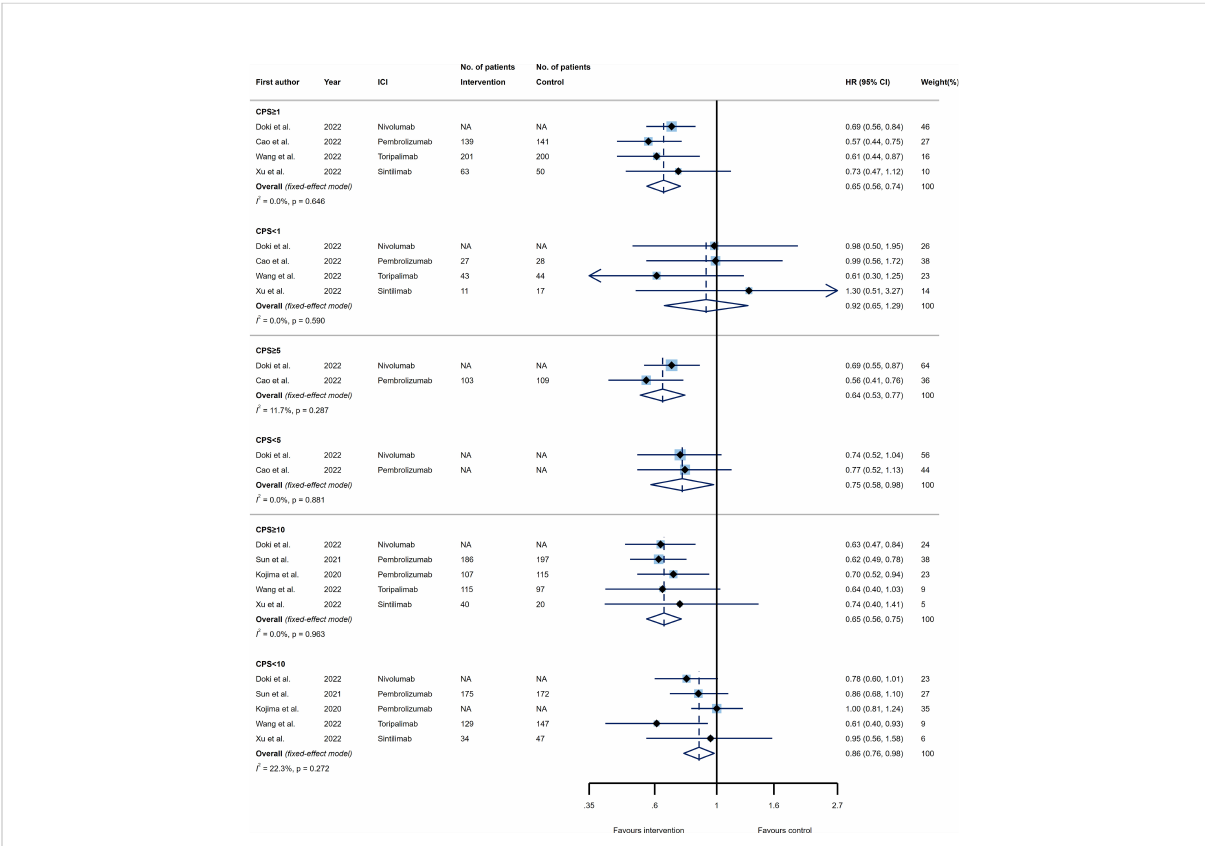
FIGURE 2 Forest plots of overall survival (OS) in PD-L1 high expression group vs . PD-L1 low expression group for the thresholds of combined positive score (CPS)=1 (upper panel), CPS=5 (middle panel), and CPS=10 (lower panel). The squares indicate weight of each study based on the fi xed or random ‐ effect model. The vertical dashed line indicates the overall pooled estimate and the diamond the 95% con fi dence interval around that pooled estimate. The forest plot was generated using STATA 17.0 (STATA Corp, LLC,